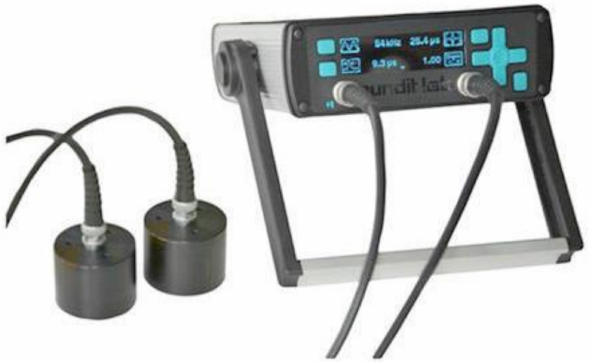
Figure 2. Photo of Pundit